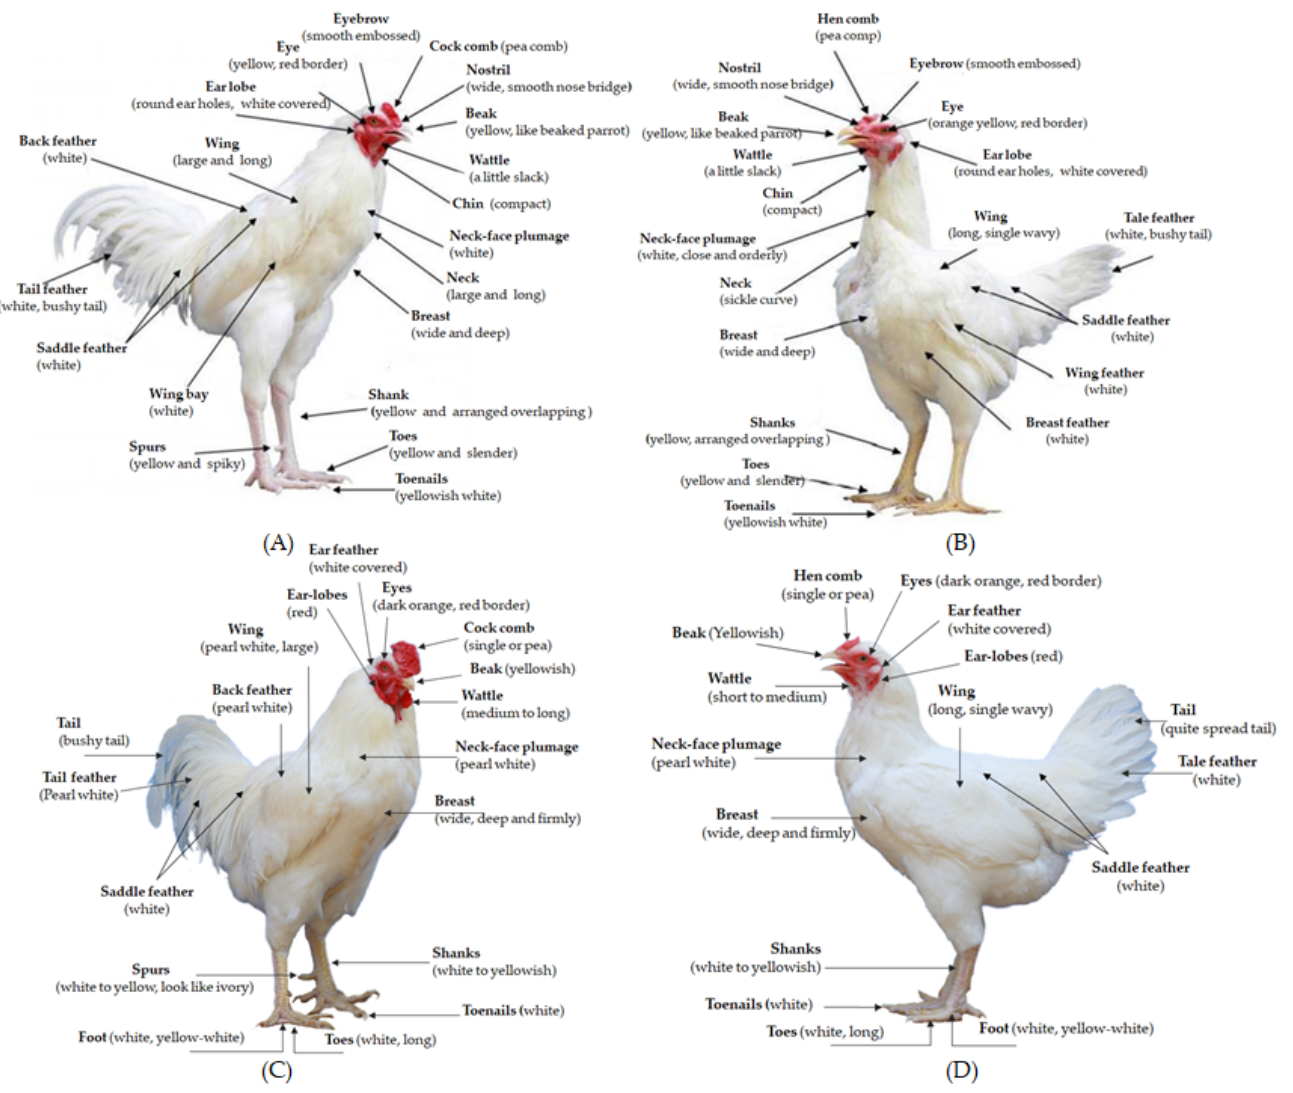
Figure 1. Morphology of male ( A ) and female ( B ) purebred Thai native chickens (Kai Shee) and male ( C ) and female ( D ) Thai synthetic chickens (Kaimook e-san1).